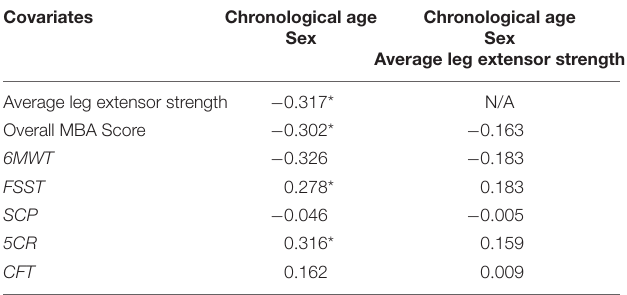
TABLE 4 | Correlations between brain-predicted age difference and functional performance measures. Covariates